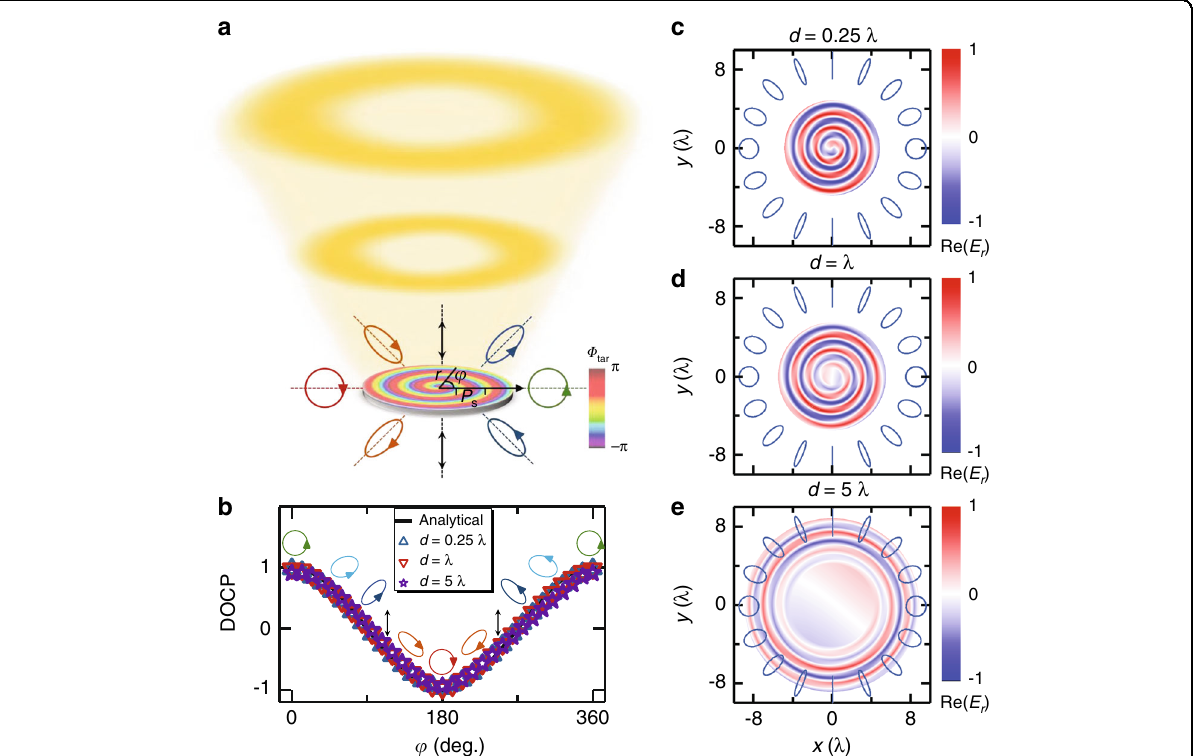
Fig. 2 Analytical calculations on a model system for complex VOF generation. a Schematic of a light beam scattered by a model metasurface exhibiting designed distributions Φ tar ð ~ r Þf ; Θ tar ð ~ r Þ ; Ψ tar ð ~ r Þg given by Eq. (3), generating a divergent vortex beam with spatially dependent polarizations. The color map on the metasurface represents the required Φ tar ð ~ r Þ distribution. b DOCP versus polar angle inside the beam computed by the GF approach on xy -planes at distance d from the metasurface. The solid line represents the analytical predictions by Eq. (3). Ellipses/circles/ arrows represent the polarization patterns at different polar angles. c – e Distributions of < E r ð Þ for the re fl ected beam on xy -planes at different distances above the metasurface, computed by the GF